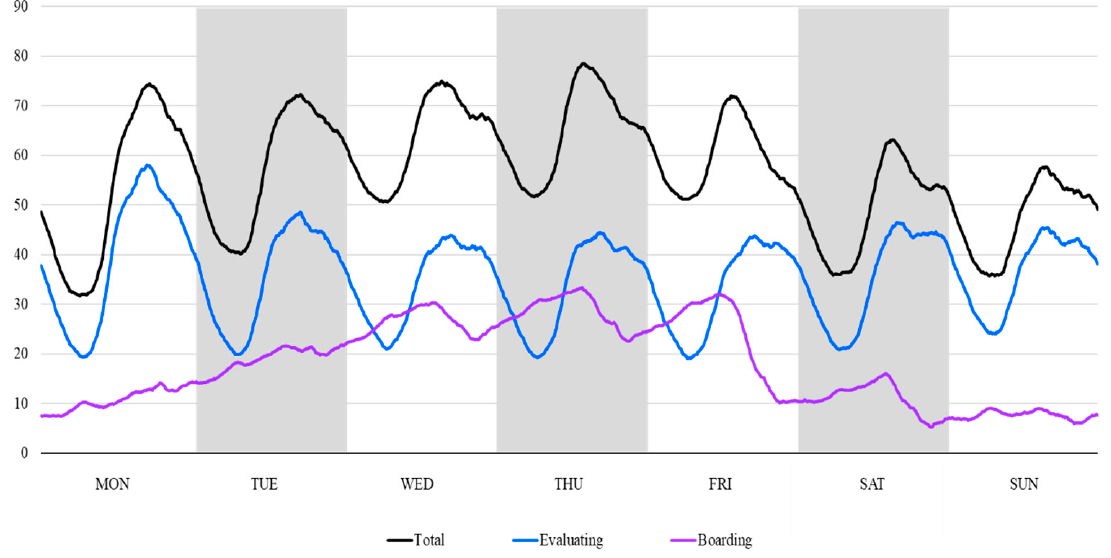
Figure 3. The hourly distribution by day of week of patients occupying the emergency department.